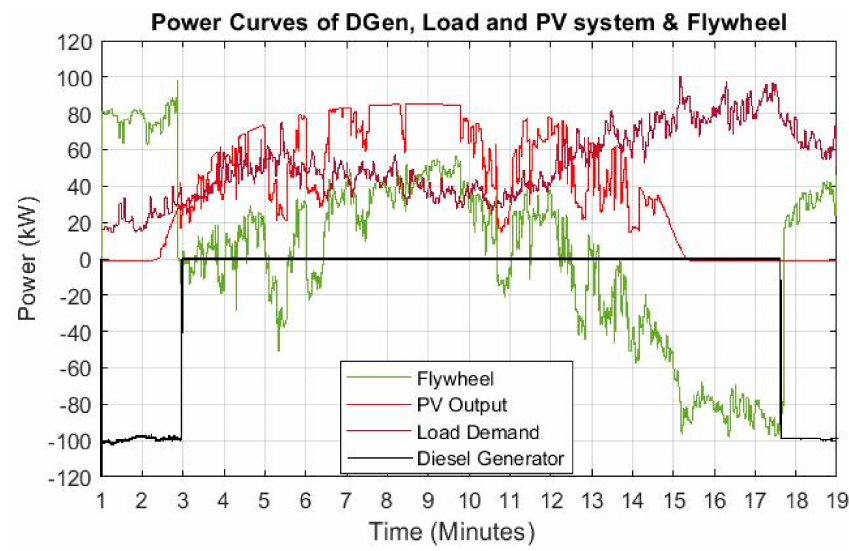
Figure 21. Combined power curves of Dgen, load demand PV system and